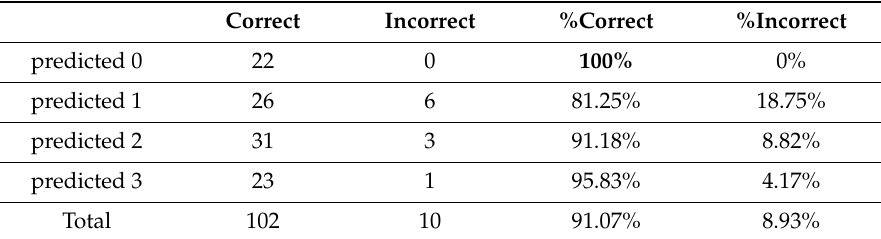
Table 8. Comparison of predicted to real rating categories.